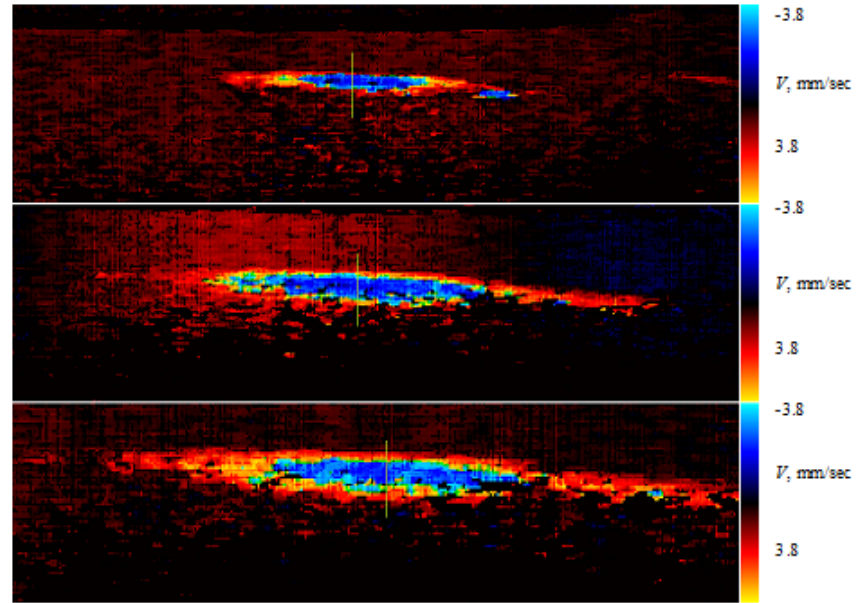
Fig. 2. The velocity map of main trunk sagittal vein in newborn rat under normal condition (a), 4 h after stress (b) and 24 h after stress